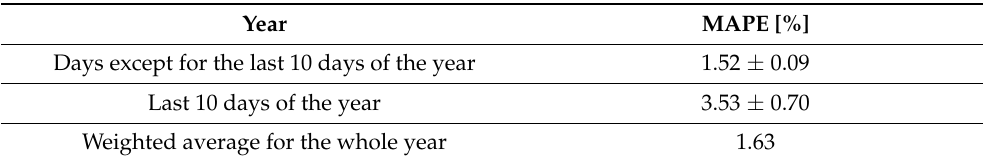
Table 3. Statistical results of numerical experiments in 24-h load pattern prediction in PPS using LSTM